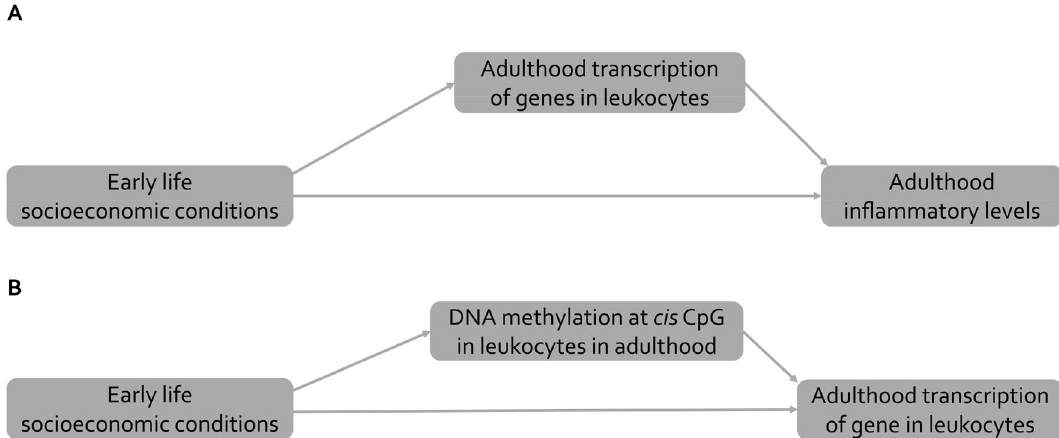
Figure 2. Causal structures. For the sake of simplicity, we do not draw confounders (age, sex, centre of blood collection). Early life socioeconomic conditions represent the exposure. ( A ) Inflammatory levels in adulthood represents the outcome, and adulthood transcription of genes in leukocytes the investigated intermediate mechanism. ( B ) Transcription level of a gene in leukocytes represents the outcome and DNA methylation levels at a specific cis CpG in leukocytes the mediating